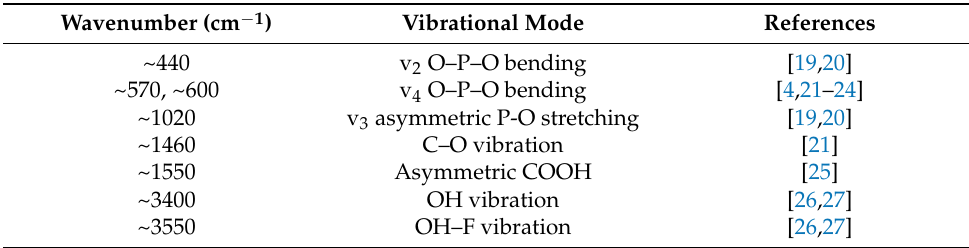
Table 3. Vibrational modes assigned for GIC and GIC1 samples.